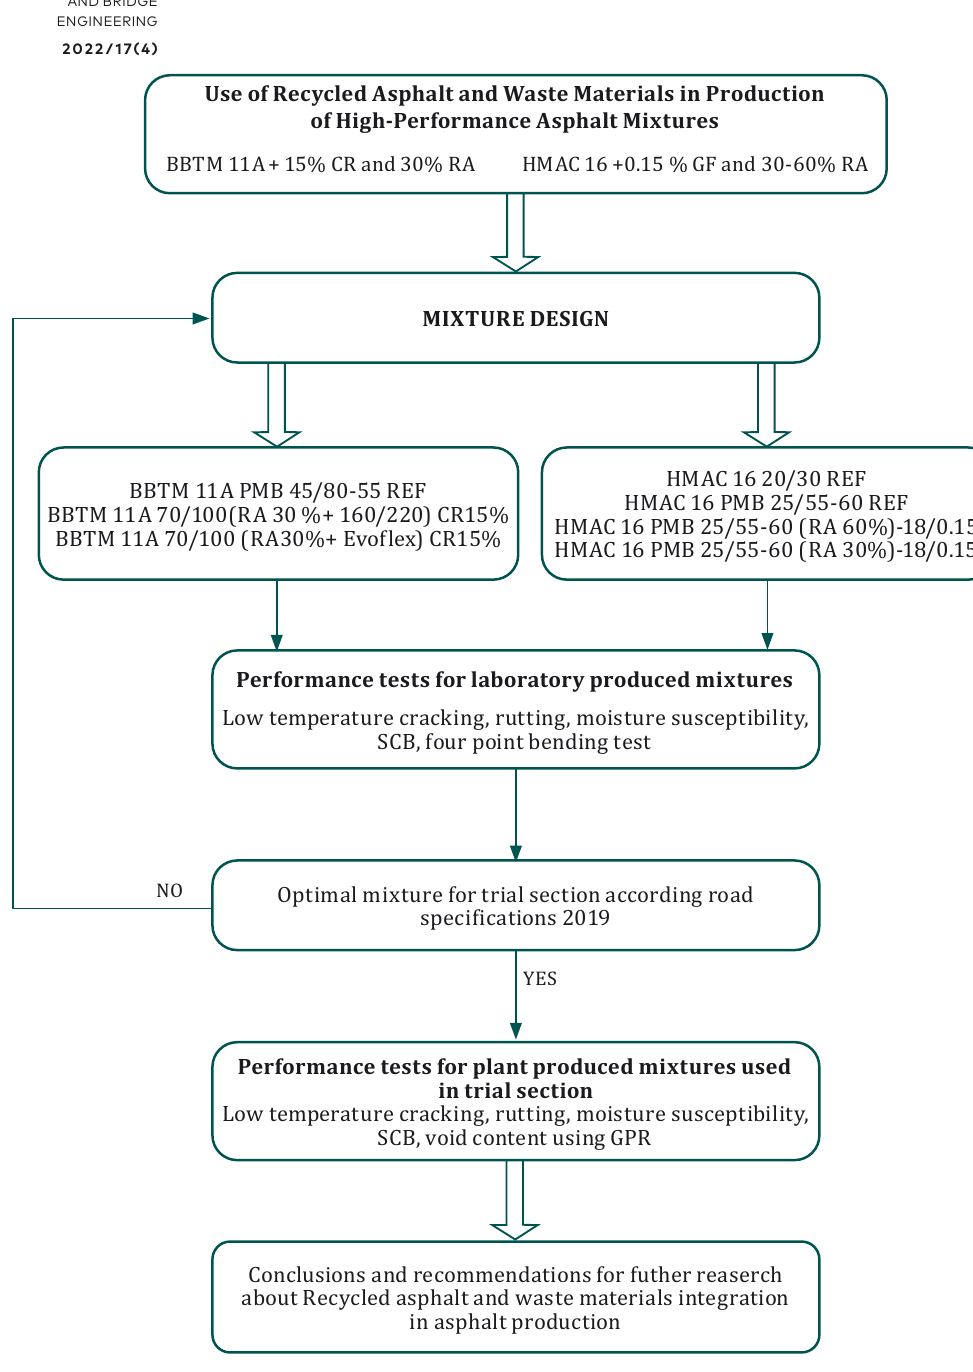
Conclusions and recommendations for futher reaserch about Recycled asphalt and waste materials integration in asphalt production Figure 2. Flow chart of the research process